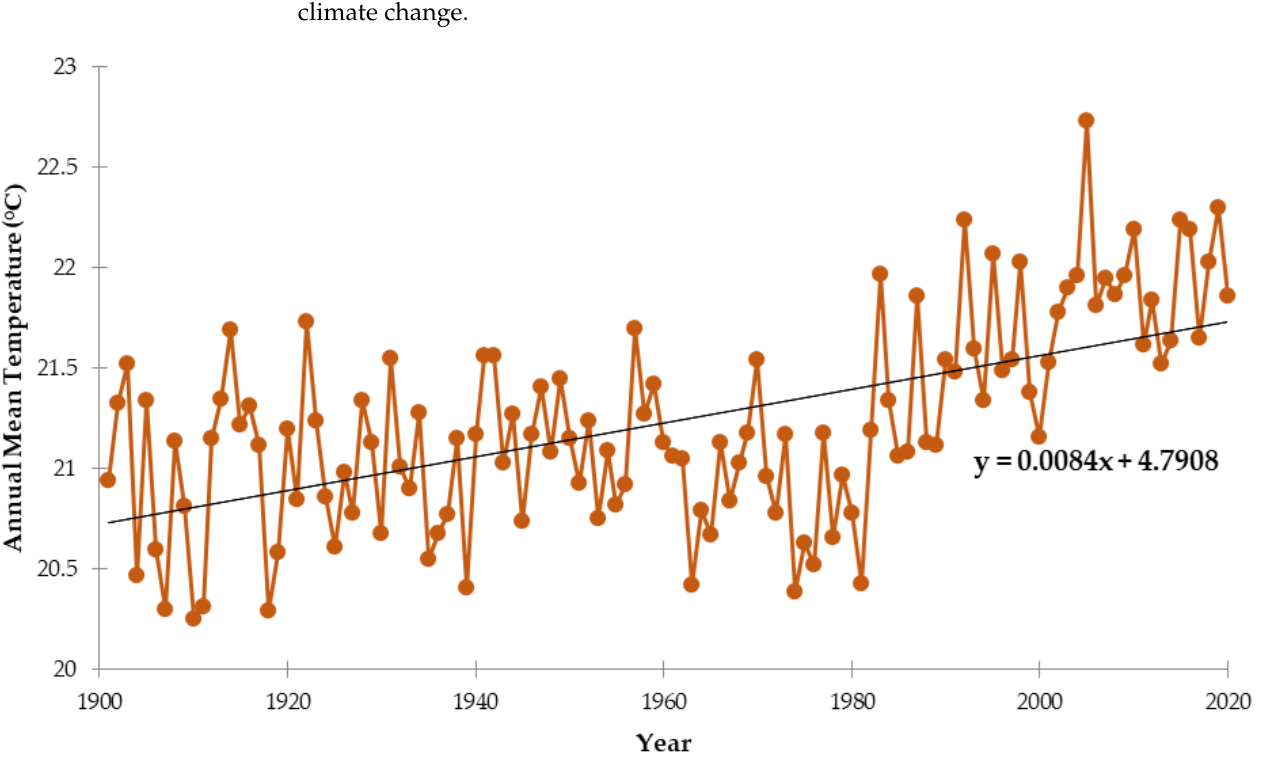
Figure 4. Temperature trend in Zimbabwe from 1901 to 2020.